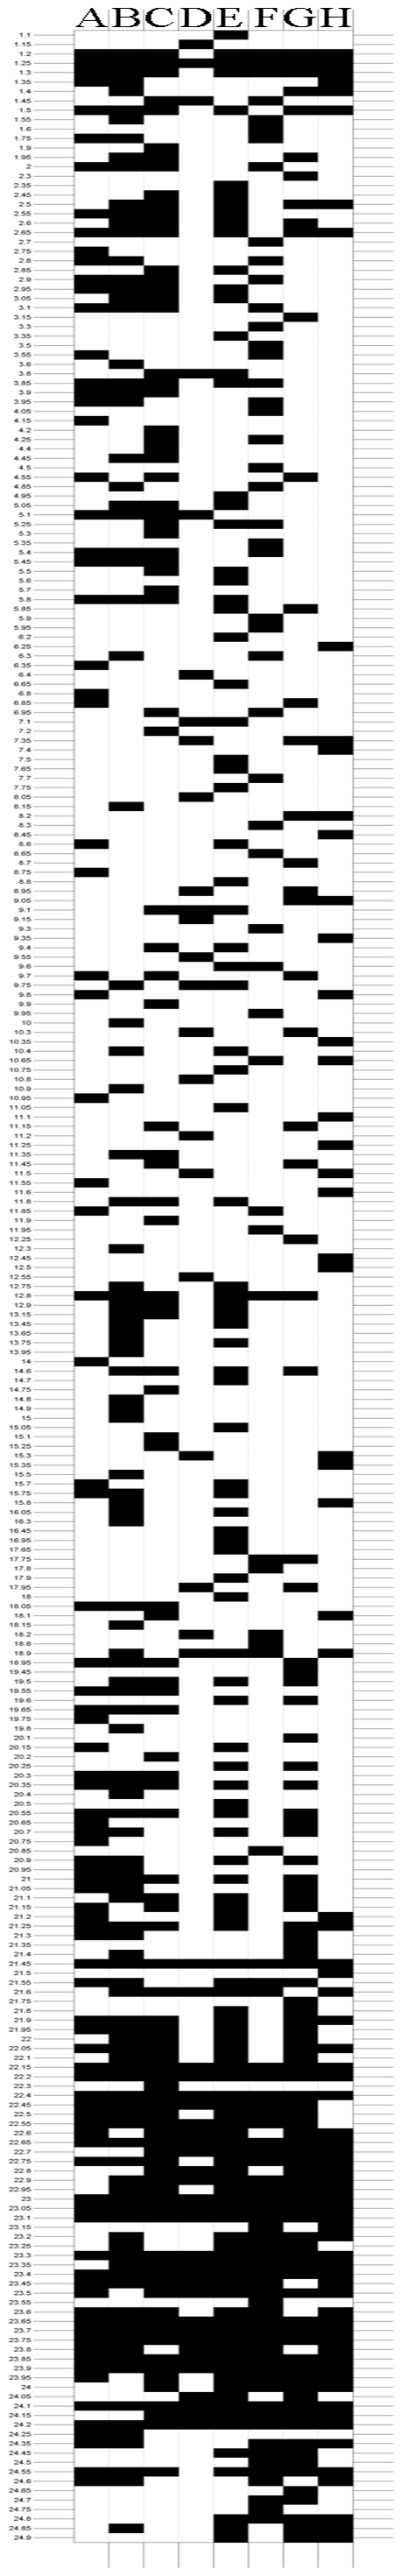
Binary plot illustrating the GC-MS chromatographic peaks (metabolites) associated with each SPME fiber.Columns represent the fibers while rows indicate peak retention times. Each extraction was performed in duplicate and replicates combined. Fiber legend: A - 75 µm CAR-PDMS, B - 85 µm CAR-PDMS, C - 50/30 µm CAR-DVB-PDMS, D - 85 µm PA, E - 65 µm DVB-PDMS, F - 7 µm PDMS, G - 100 µm PDMS, H - 60 µm PEG.